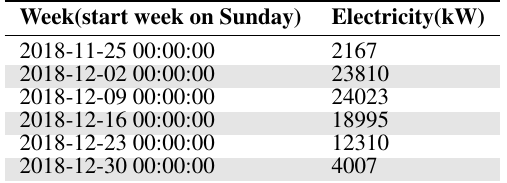
Table 2. Weekly electricity demand in December Week(start week on Sunday) Electricity(kW)